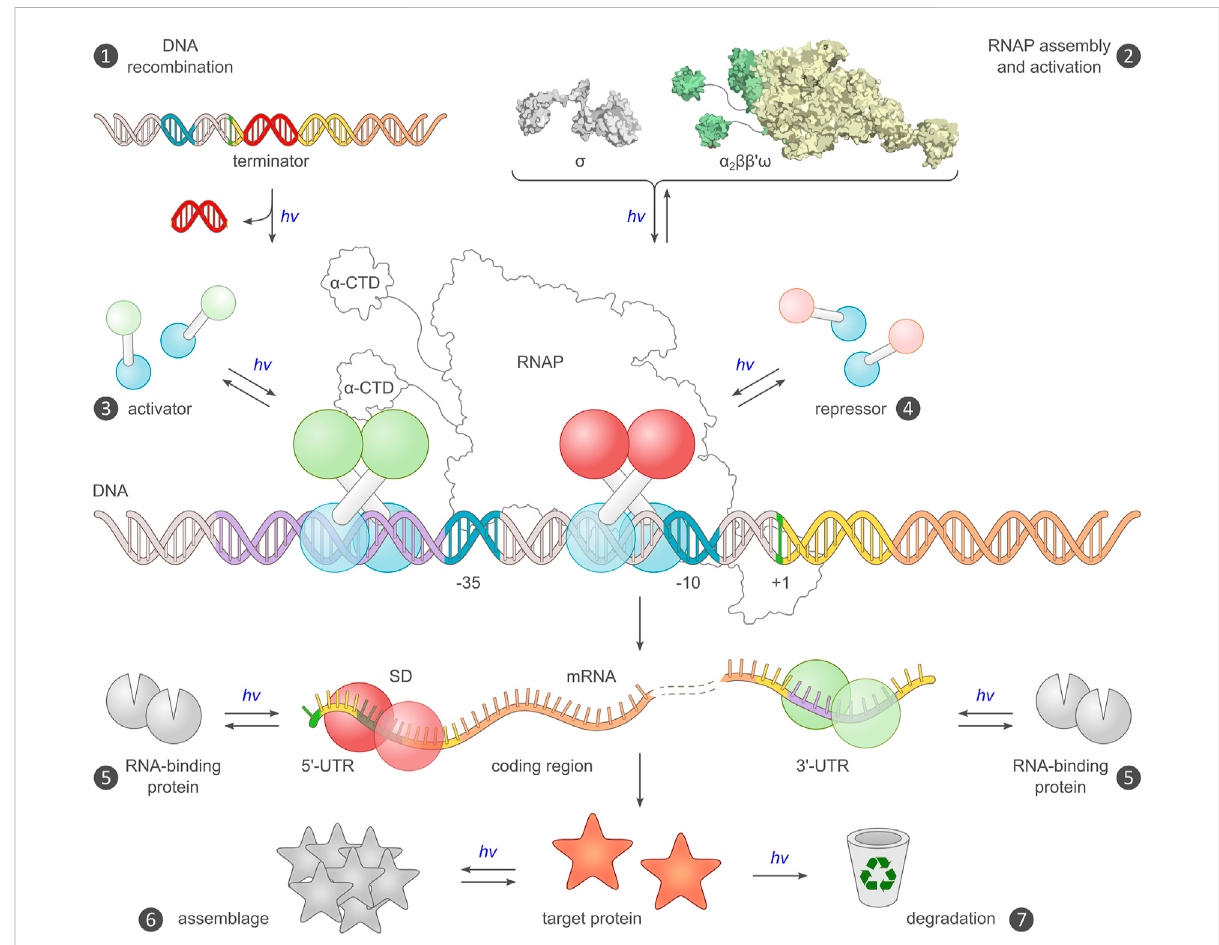
FIGURE 3 Existingandpotentialtoeholdsfortheoptogeneticcontrolofbacterialgeneexpression.ExpressionrequiresaDNAtemplateencodinganintact transcriptional unit, and the provision of this unit can be modulated by recombination events (mechanism ❶ ) (Sheets et al., 2020). Alternatively, the assembly of a functional RNA polymerase (RNAP) holoenzyme can be modulated ( ❷ ), for example by controlling the association of the endogenous core polymerase ( α 2 ββ ′ ) with its σ factor, or by reconstitution of a split viral polymerase (Baumschlager et al., 2017; Han et al., 2017). The main checkpointfortranscriptionisinitiation,whichispromotedbyactivatorproteins,often via productiveinteractionswiththeC-terminaldomainofthe RNAP α subunits ( α -CTD), and hindered by repressors ( ❸ , ❹ ). Prokaryotic activators and repressors are usually homodimeric, and their activity can hence be governed by controlling their assembly by light, either directly e.g., in case of EL222 (Nash et al., 2011), or indirectly in case of the widespread two-component systems (Levskaya et al., 2005; Möglich et al., 2009; Tabor et al., 2011). At the mRNA level, expression control can be accomplished by directing RNA-binding proteins e.g., PAL (Weber et al., 2019), to the 5 ′ - and 3 ′ -untranslated regions (UTR) of the transcript ( ❺ ). Binding to the 5 ′ -UTR may mask the ribosome-binding site (or, Shine-Dalgarno [SD] sequence) and thereby interfere with translation initiation (Ranzani et al., 2022). Alternatively, binding to the 3 ′ -UTR could be harnessed for regulating intracellular RNA stability (Tang and Guest, 1999). Post expression,targetproteinscanbecontrolled bybindingto otherproteinsorsequestrationintoproteinclusters,which mayincuractivitymodulation ( ❻ ),orbygoverningtheirintracellularlifetimeandeventualdegradation( ❼ ).Beyondthegenericstrategiesintheschematic,numerousproteinswere also subjected to light-dependent allosteric control via direct fusion with a photoreceptor